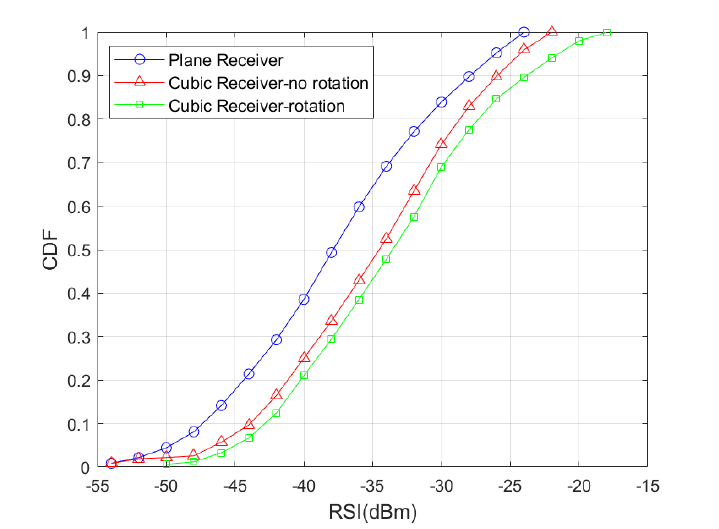
Figure 6. The CDF of RSI for Φ 1/2 = 30 ◦ .